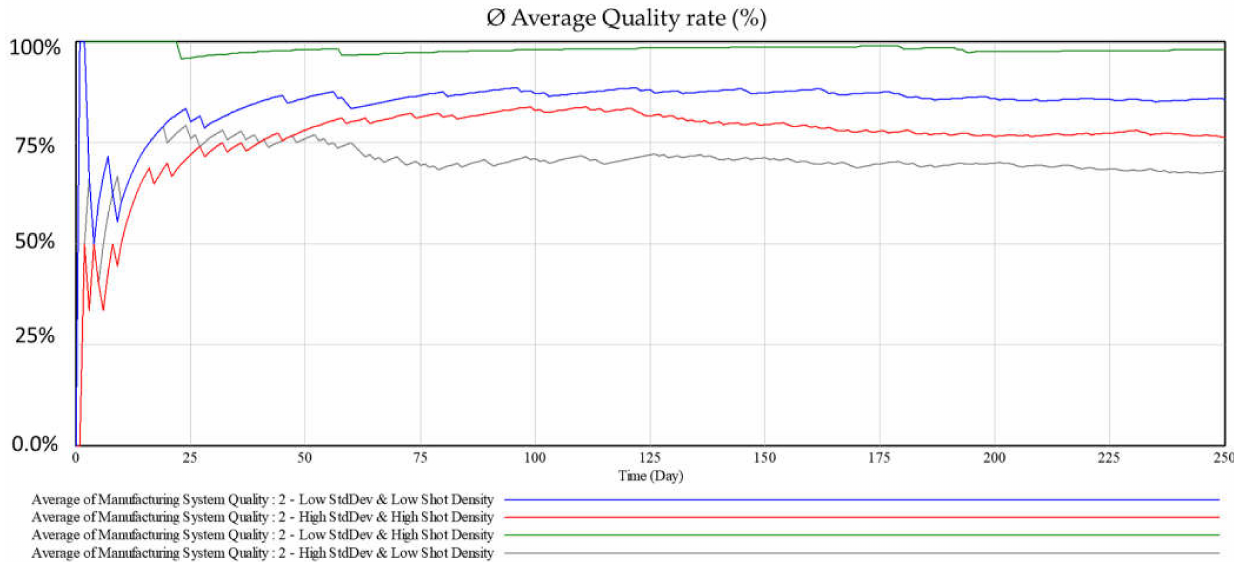
Figure 10. Average quality rate (%) results for shot peening parameters: low and high average and standard deviation of shot